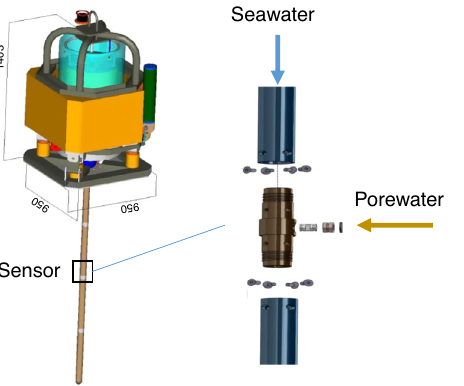
Fig. 8 Piezometer. Scheme of the piezometer equipped with differential pore pressure and temperature sensors and ballasted with lead